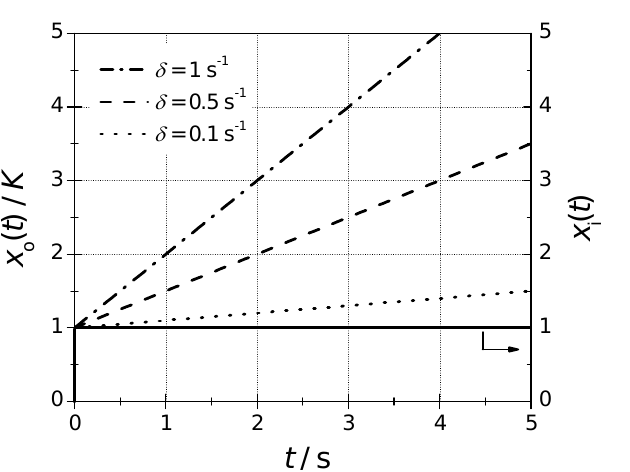
Figure 9. Normalized sensor output signal x o / K (interrupted lines) for a unit step input (solid line) when considering a time-dependent sensor sensitivity (drift) with di ff erent drift rates δ